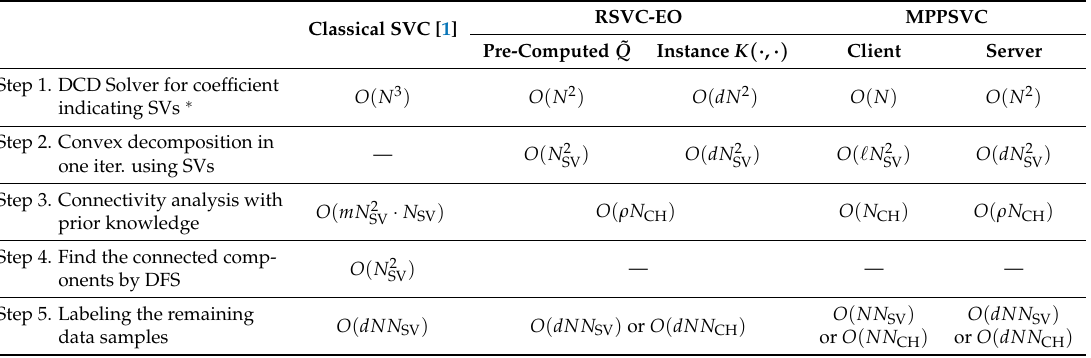
Table 1. Time complexities of the proposed